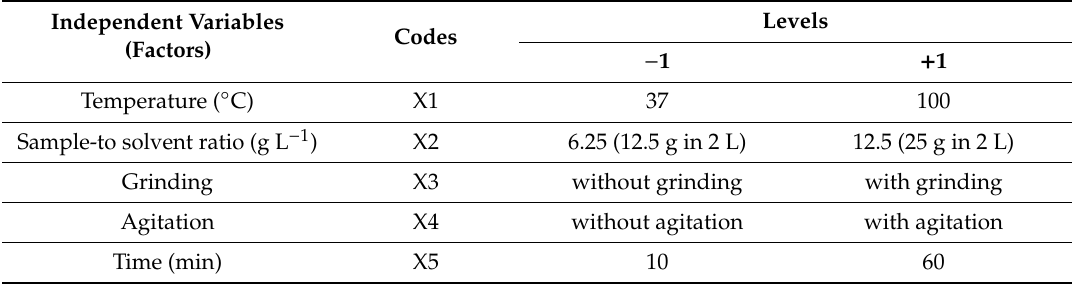
Table 1. Experimental levels and codes for independent variables investigated in the factorial screening